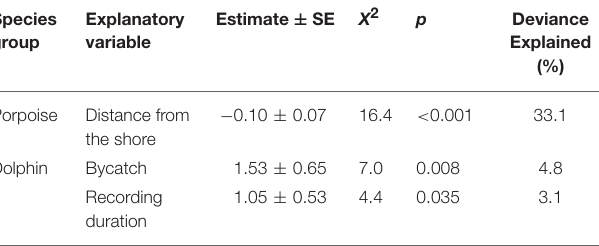
(presence-absence;